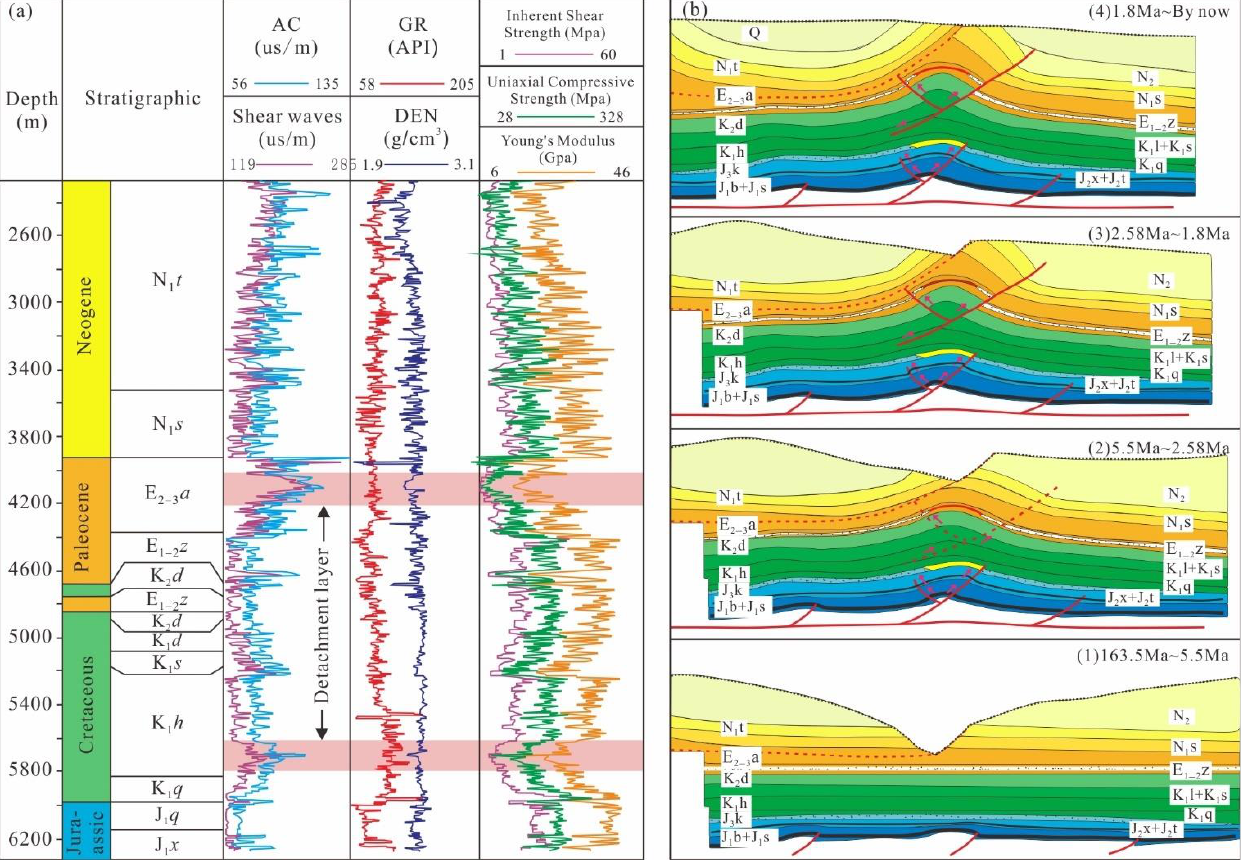
Figure 3. Rock mechanics structure columnar section ( a ) and inversion section of Tulugu anticline model ( b ) in southern Junggar Basin.